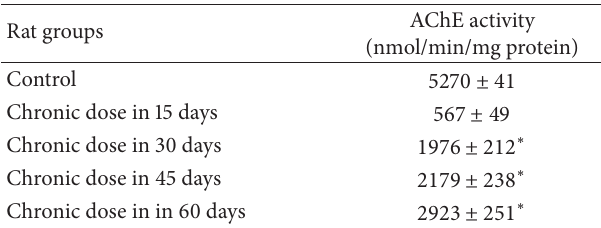
Table 2: AChE activity variations in presence of chronic dose (2mg/kg) of Mn in the different long time intervals. Asterisk symbols indicate significant changes ( 𝑃 < 0.01